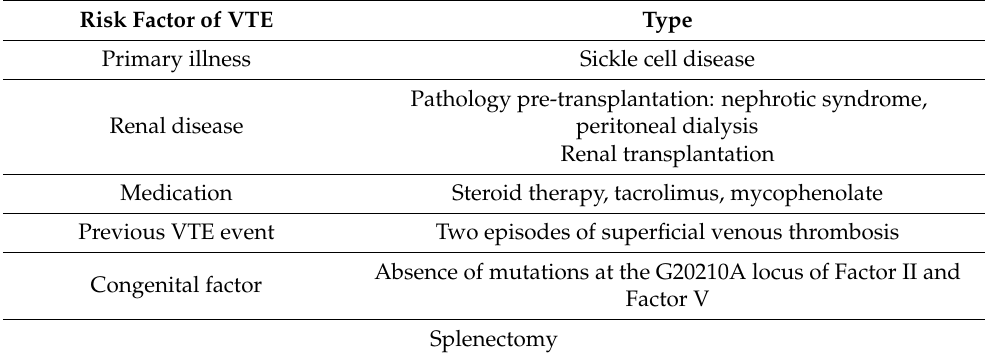
Table 1. Main risk factor of VTE in the